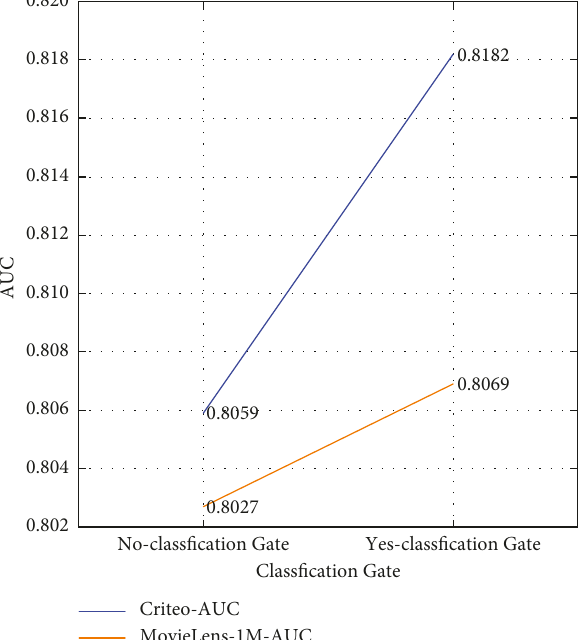
Figure 11: The classification gate of AUC in model CCPIN.